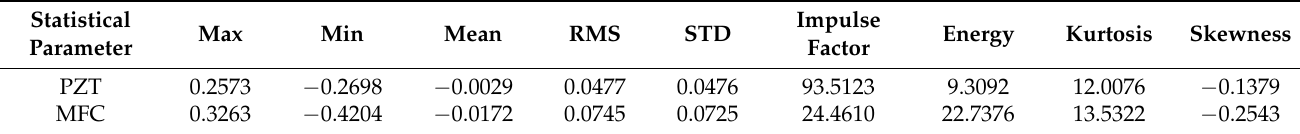
Table 2. Statistical Parameter for Captured Signals by Low-cost AE